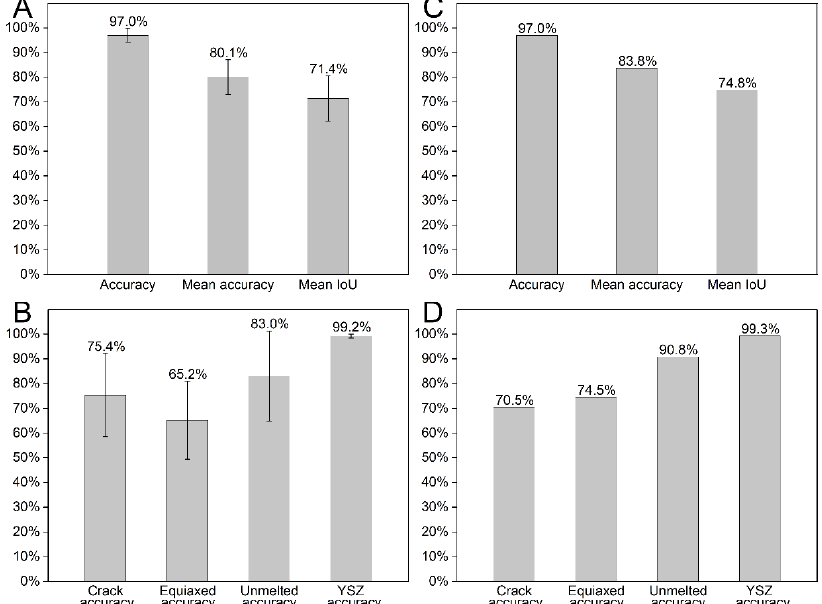
Figure 9. ( A , B ) Metrics of the trained model evaluated using 57 test images: ( A ) Overall metrics and ( B ) accuracy for each class of microstructure; the error bars represent standard deviations. ( C , D ) Metrics of the trained model evaluated using one hypothetical image containing all the test images: ( A ) overall metrics and ( B ) accuracy for each class of microstructure.